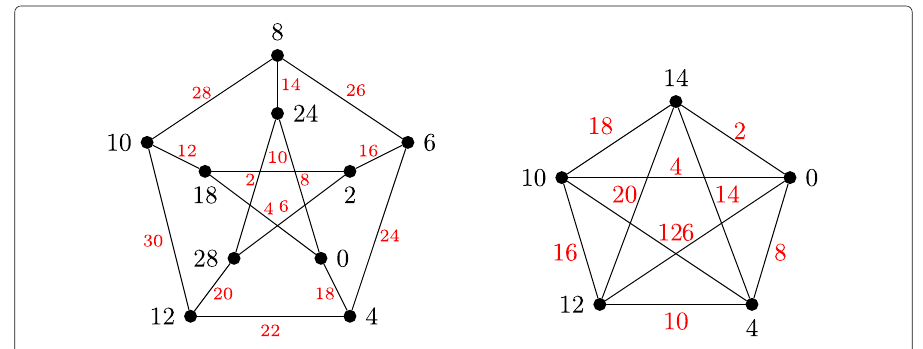
Fig. 1 An edge even graceful labeling of Peterson graph and the complete graph K